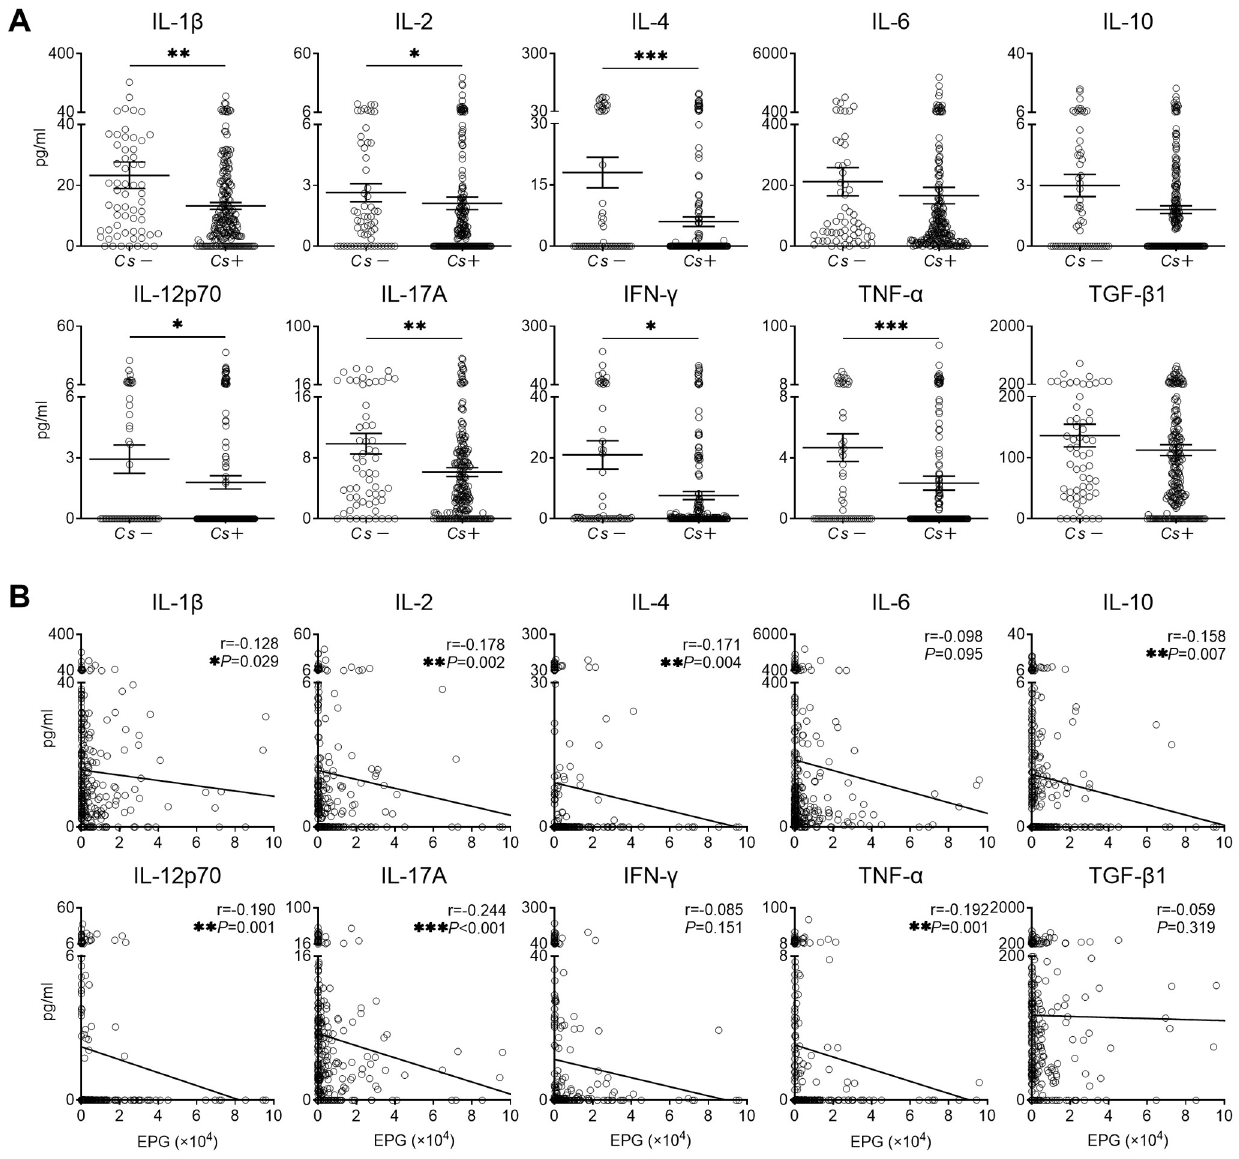
Fig 3. Serum levels of cytokines in Cs - and Cs + individuals. (A) Serum levels of IL-1 β , IL-2, IL-4, IL-6, IL-10, IL-12p70, IL-17A, IFN- γ , TNF- α and TGF- β 1 in Cs - individuals (n = 60) and Cs + individuals (n = 229). (B) Spearman’s correlation analysis between EPG and serum levels of IL-1 β , IL-2, IL-4, IL-6, IL-10, IL-12p70, IL-17A, IFN- γ , TNF- α and TGF- β 1 (n = 289). Cs : C . sinensis infection, EPG: eggs per gram of feces. The data were shown as the mean ± s. e.m., � P < 0.05, �� P < 0.01, ��� P < 0.001, Mann-Whitney U test in (A) , Spearman’s correlation test in (B) .